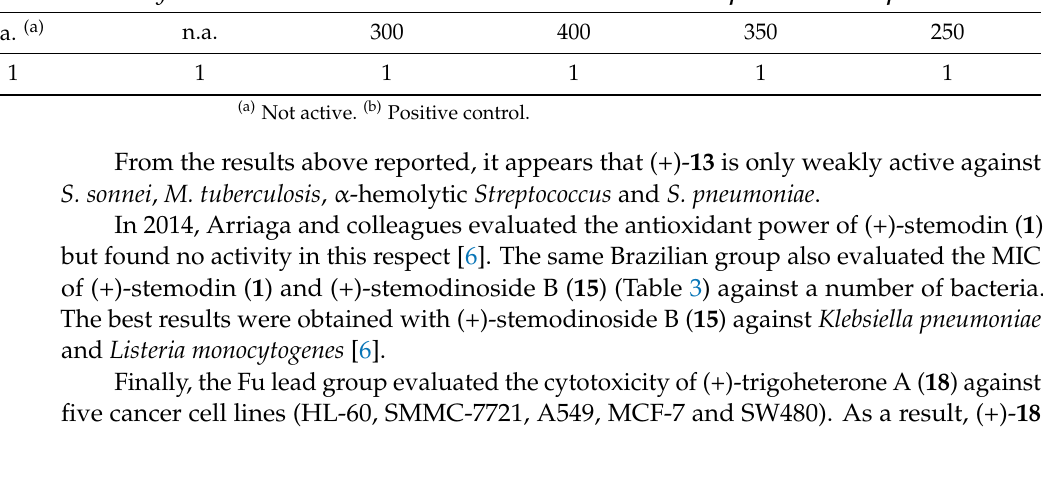
Table 2. Antibacterial Activities of (+)- 13 towards different bacterial strains. All values were determined by the paper-disk method and are expressed in terms of minimal inhibitory amount (MIA; in µ g/disk) [11]. Compound